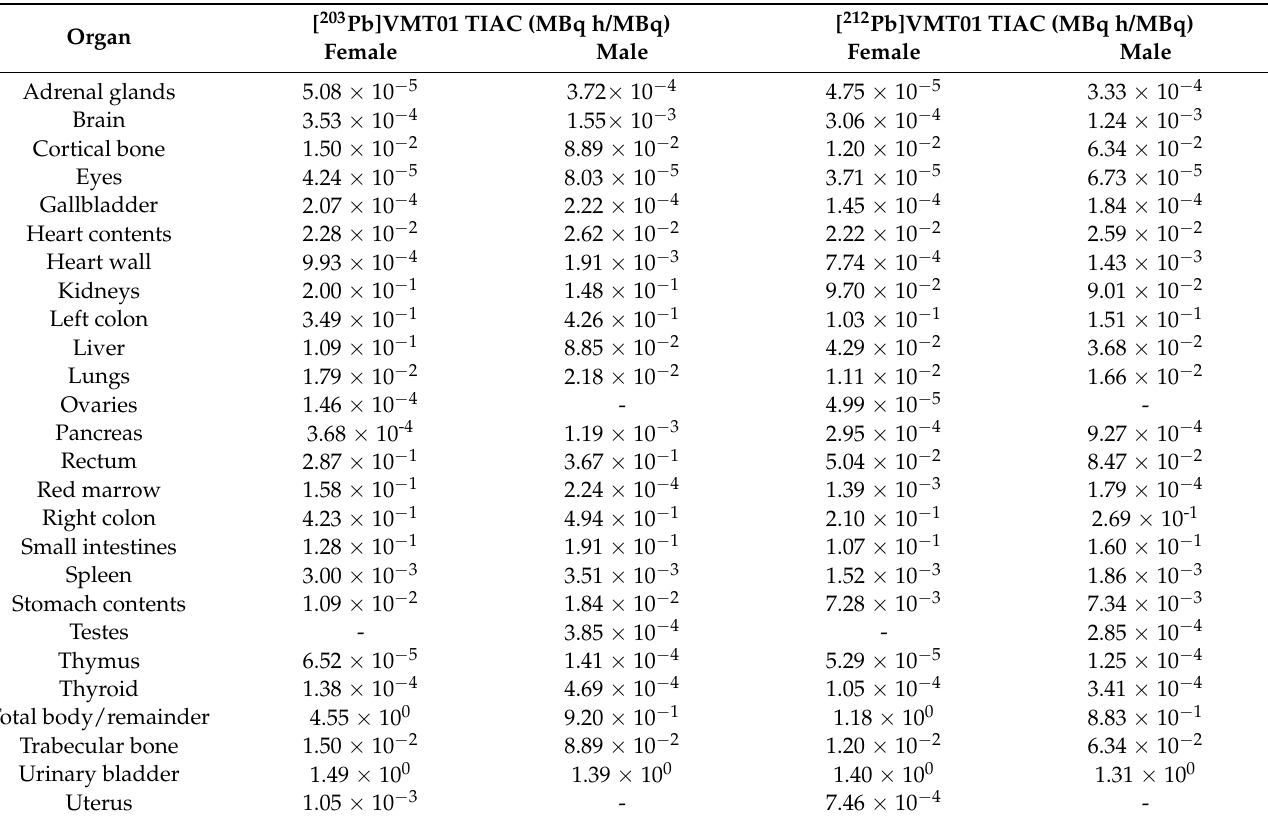
Table 1. [ 203 Pb]VMT01 and [ 212 Pb]VMT01 time-integrated activity coefficients.